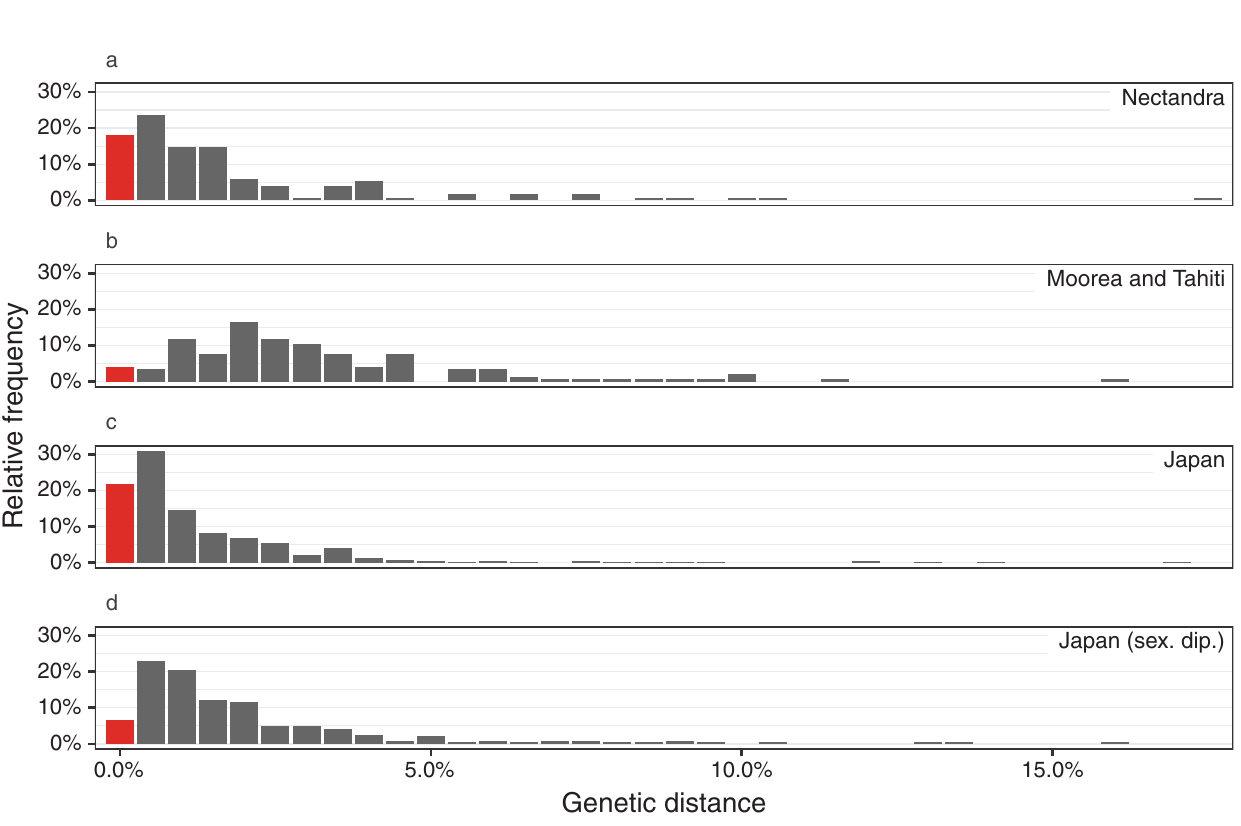
Fig 3. Minimum interspecific rbcL distances for selected pteridophyte floras. (a) Nectandra, (b) Moorea and Tahiti, (c) Japan (all species), and (d) Japan (sexual diploids only). Red bar indicates interspecific distance of zero, i.e., species that cannot be distinguished using rbcL .